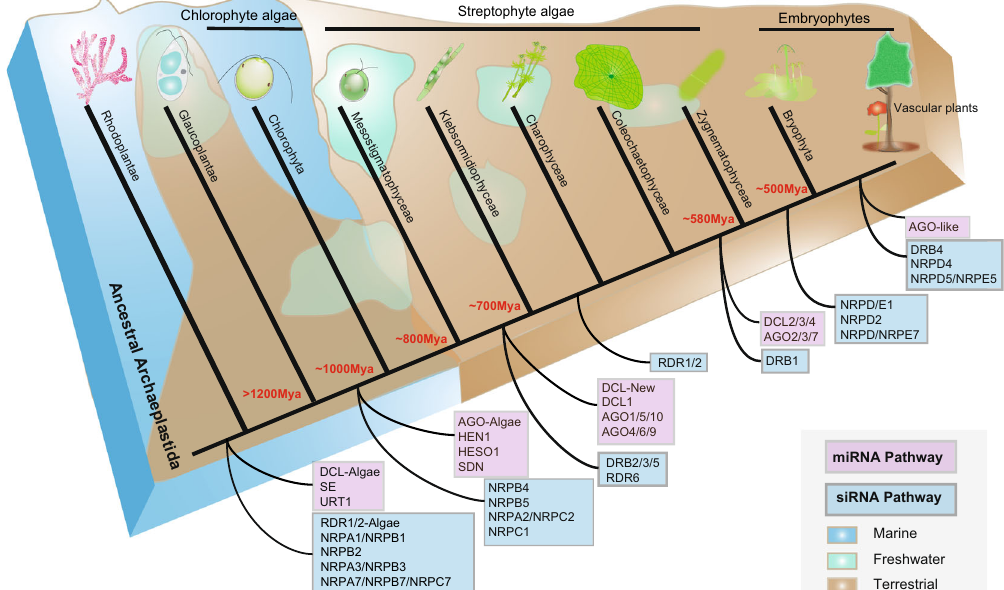
Fig. 6 A schematic presentation of the evolution of small RNA pathway-related genes across Archaeplastida based on the phylogenetic analyses presented in Figs. 3 – 5 and 6 Supplementary Figs. 1 – 10. Blue and purple boxes represent the siRNA and miRNA pathway-related genes, respectively. Habitat distribution of different taxa is shown in different colors: brown (subaerial/terrestrial), light green (freshwater), blue (marine). Mya (in red) indicates divergence time in million years for the next node. Further details are presented in the “ Results ” and “ Discussion ”